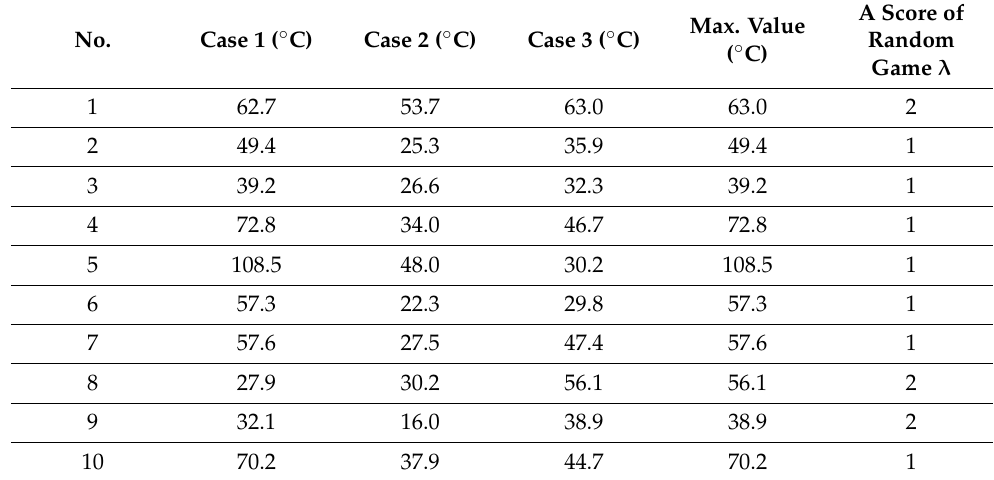
Table 5. Results of the reproducibility test and score value of random game λ